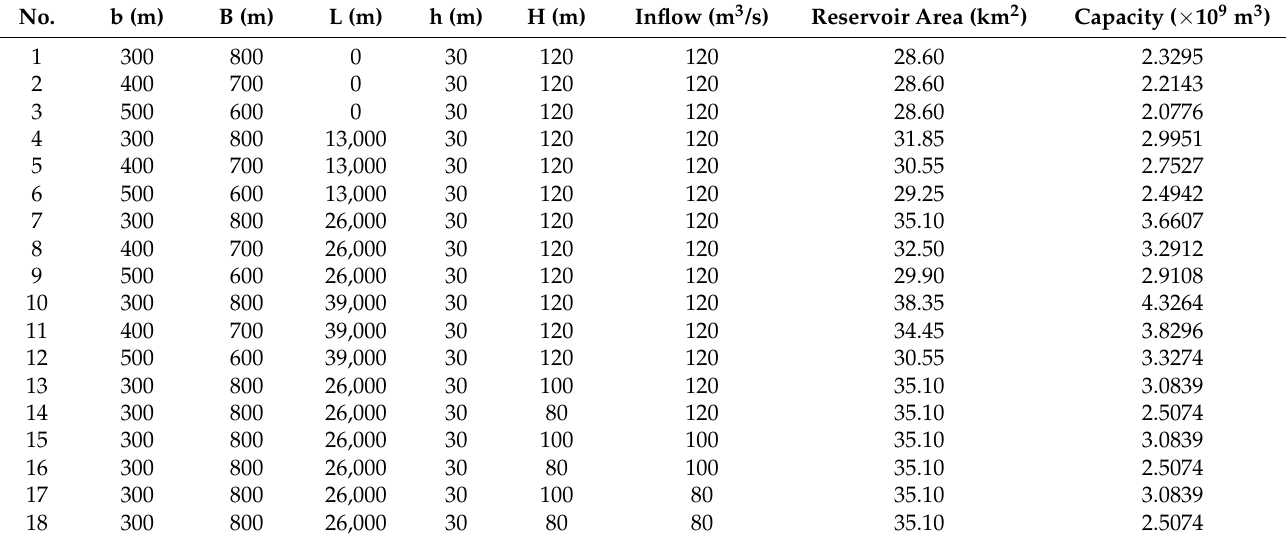
Figure 6. Schematic diagram of reservoir model. Table 1. Design of training cases.